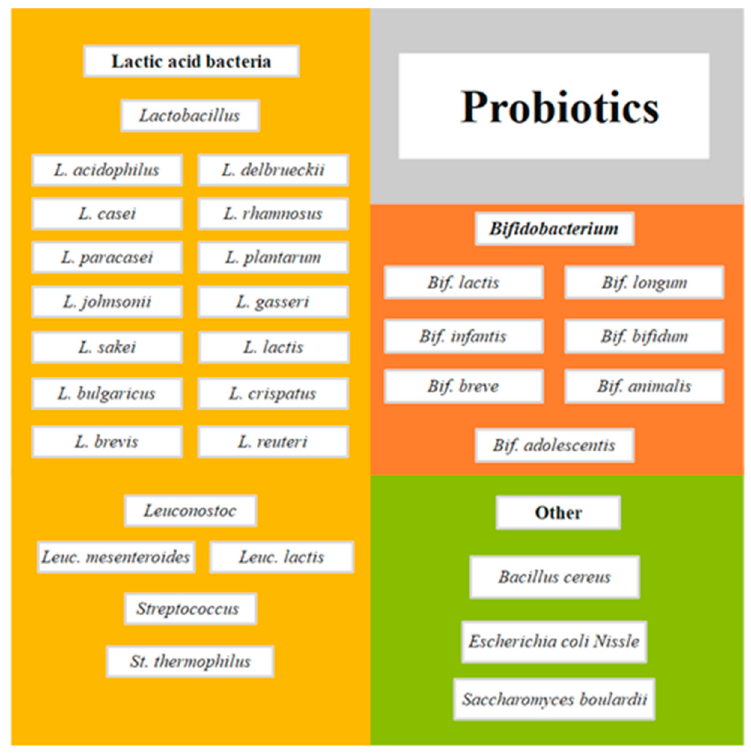
Figure 1. Selected species of microorganisms as probiotics adapted from Moradi et al. [6].